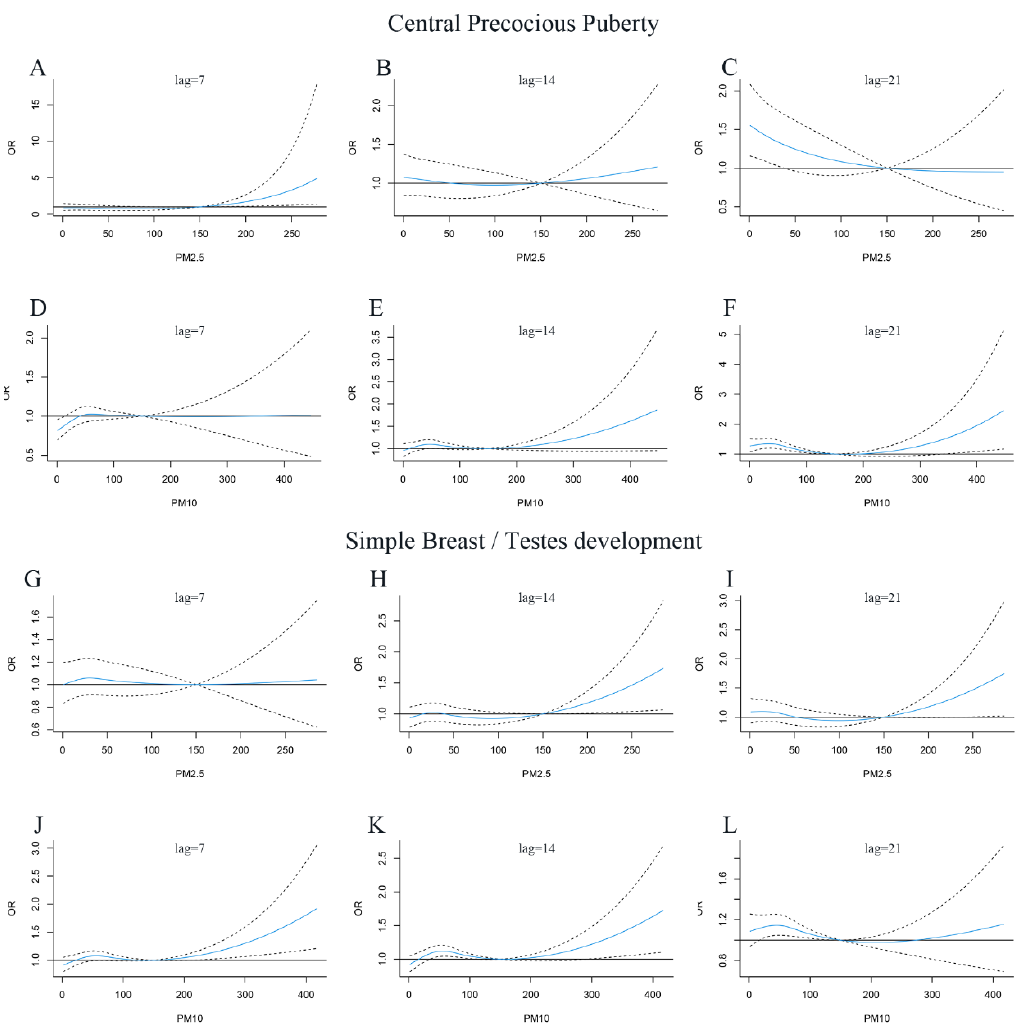
Figure 5. Lag-specific odds ratio (OR) and 95% confidence interval (CI) of central precocious puberty and simple breast/testes development with up to 28 days of exposure to PM 2.5 and PM 10. ( A ): Central precocious puberty, PM 2.5, lag = 7, ( B ): Central precocious puberty, PM 2.5, lag = 14, ( C ): Central pre- cocious puberty, PM 2.5, lag = 21, ( D ): Central precocious puberty, PM 10, lag = 7, ( E ): Central preco- cious puberty, PM 10, lag = 14, ( F ): Central precocious puberty, PM 10, lag = 21. ( G ): Simple breast/testes development, PM 2.5, lag = 7, ( H ): Simple breast/testes development, PM 2.5, lag = 14, ( I ): Simple breast/testes development, PM 2.5, lag = 21, ( J ): Simple breast/testes development, PM 10, lag = 7, ( K ): Simple breast/testes development, PM 10, lag = 14, ( L ): Simple breast/testes development, PM 10, lag = 21. The dotted line and solid line indicate OR and 95% CI, respectively.